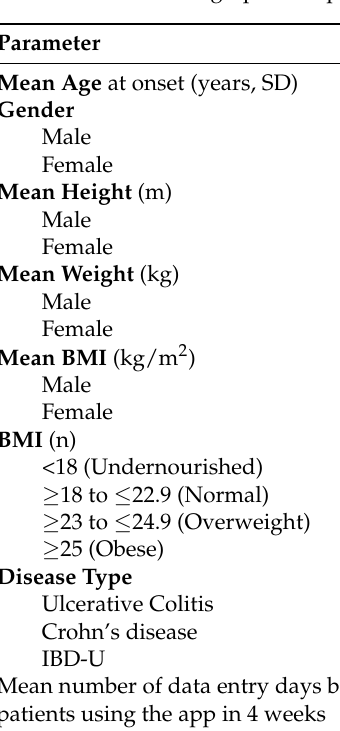
Table 1. Baseline demographics of patients enrolled in validation study ( n =